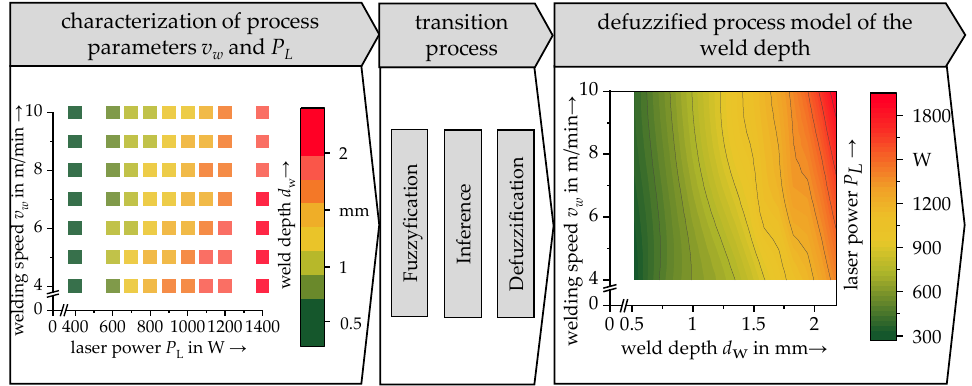
Figure 6. Transfer process of a discretized model for describing the relationships between the weld depth and process parameters into a defuzzified, continuous model as a basis for identifying appropriate controller reactions.